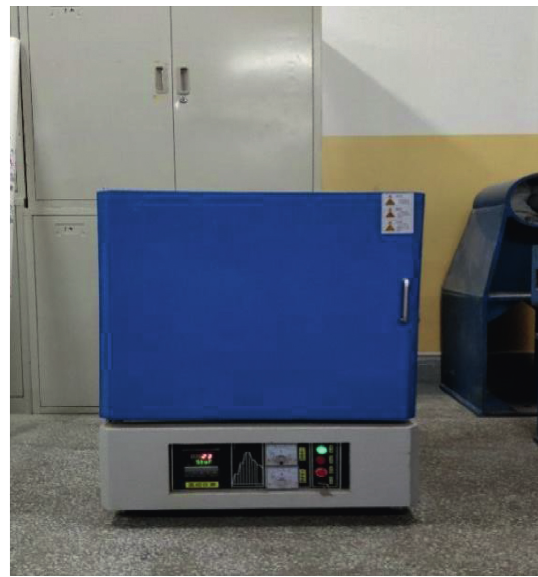
Figure 1: Box-type resistance furnace.